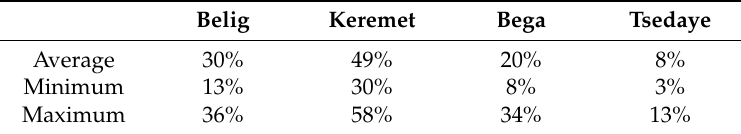
Figure 13. Comparing seasonal herd presence during the Belig ( a ), Keremet ( b ), Bega ( c ) and Tsedaye ( d ) seasons with the no migration option ( upper ) (scale 1:7,900,000). Table 7. Percentage of herds migrating, by season.